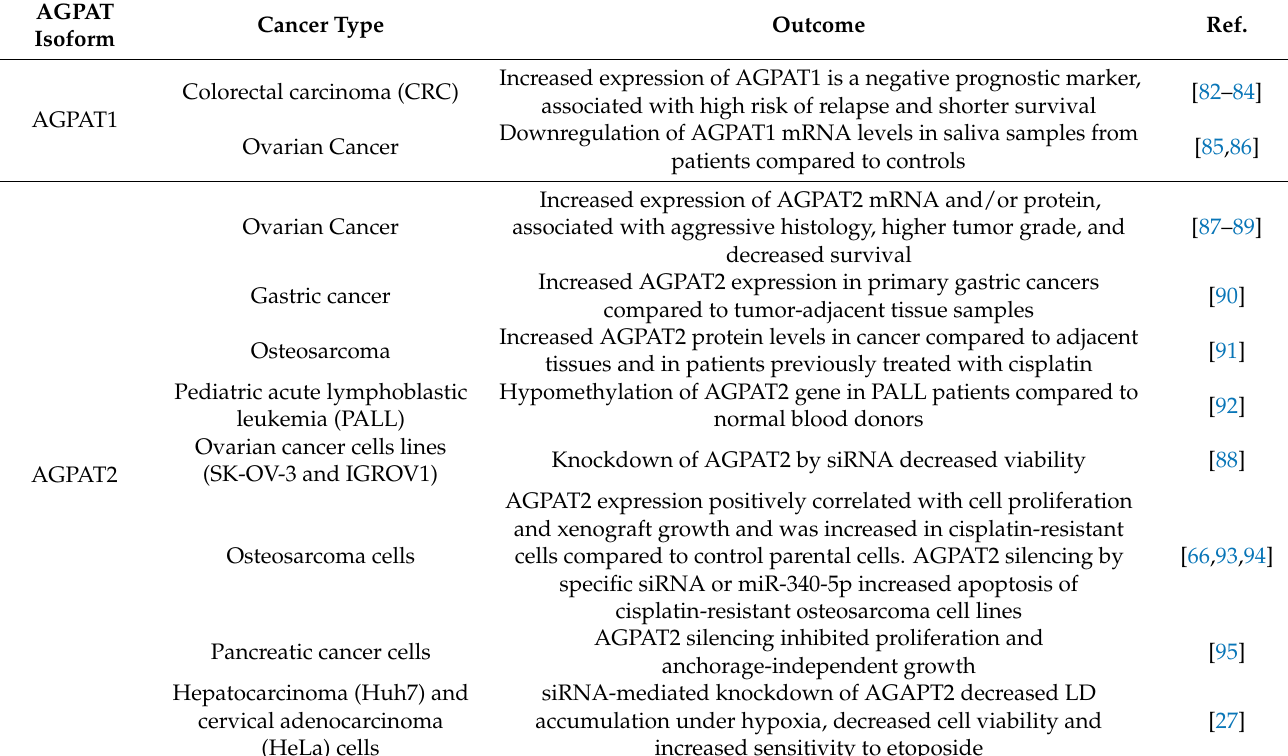
Table 1. Representative role of AGPAT isoforms in cancer